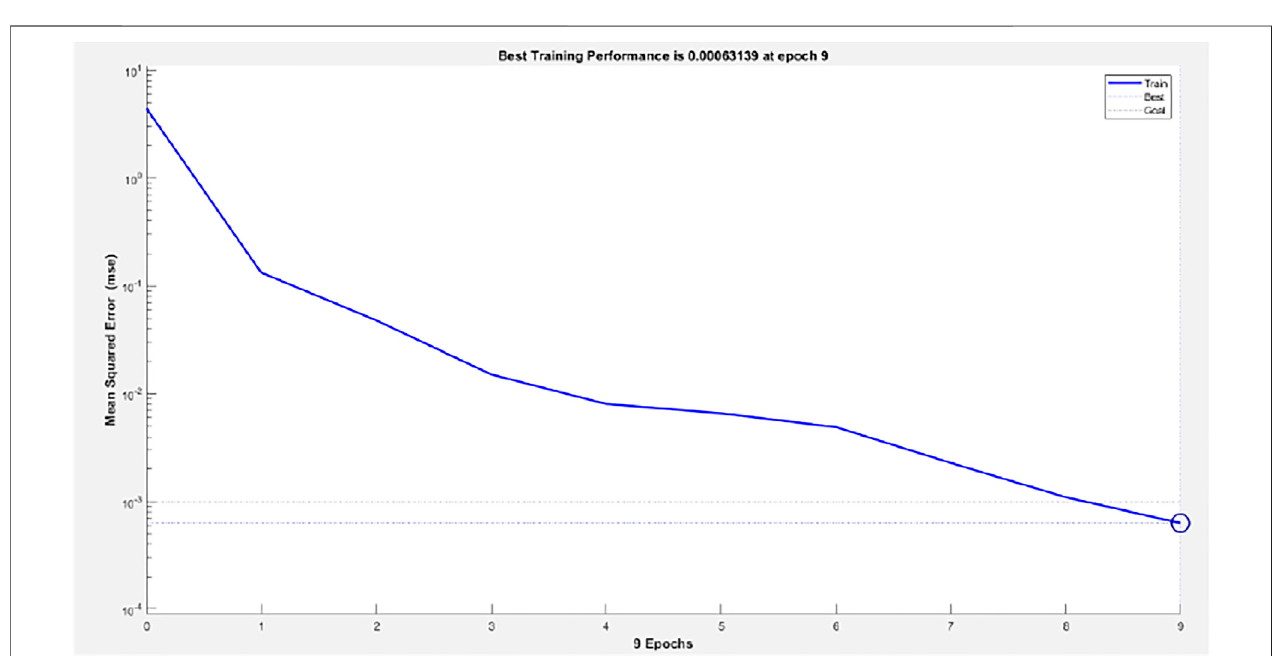
FIGURE 10 | BP neural network error comparison